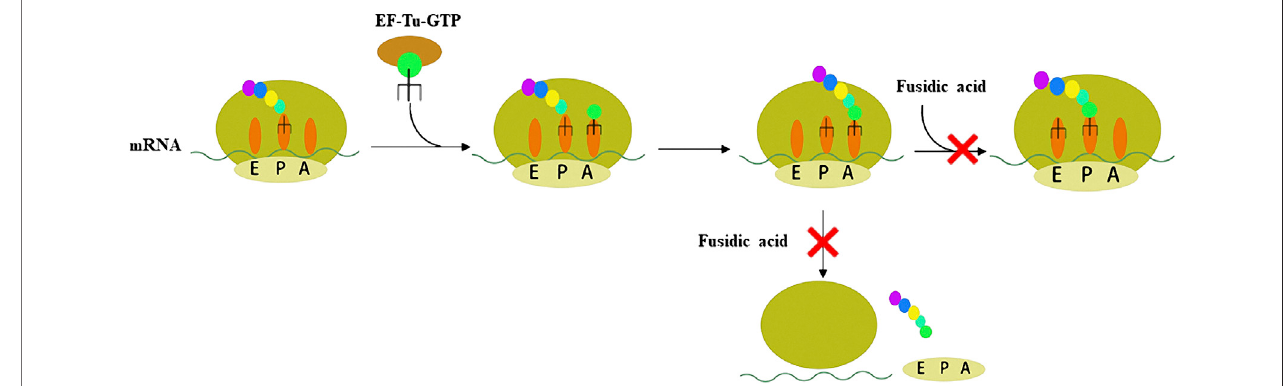
FIGURE 1 | Schematic representation of the two steps of peptide synthesis that FA blocks by binding to the EF-G-GDP complex.